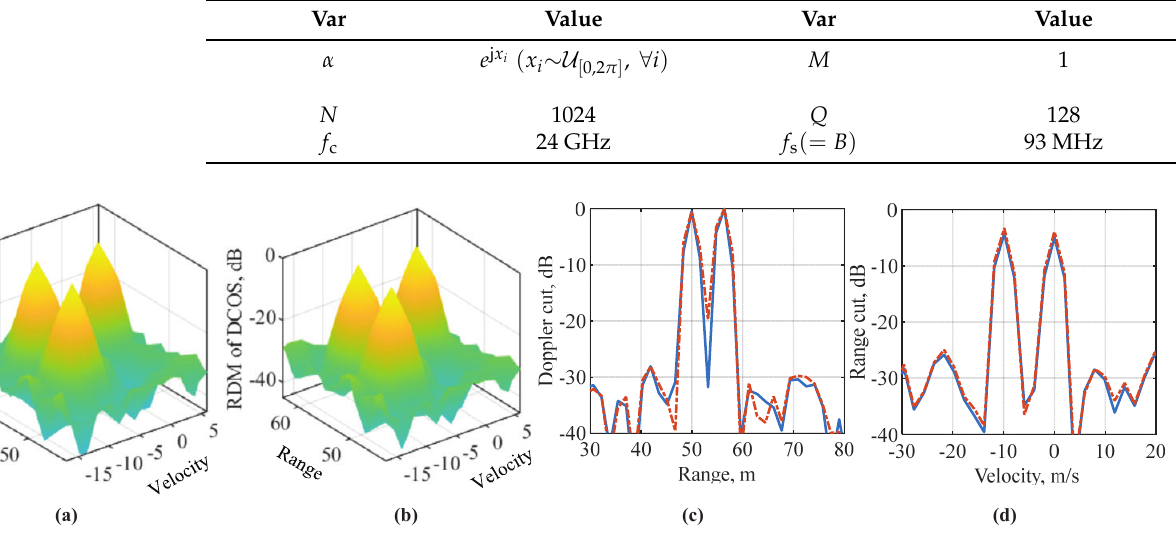
Figure 8. Illustration of target detection, where COS-RDM is given in ( a ), DCOS-RDM in ( b ), the range cuts at v = − 10 m/s are shown in ( c ) and the velocity cuts at r = 56 m in ( d ). Most settings in Table 3 are again used here, except that the number of OFDM symbols is M = 256 and the hamming window is used in (8) and (18) for both range and velocity measurements. In addition, three targets are set here. Their ranges and velocities are [ 50,56, 56 ] m and [ − 10, − 10,0 ] m/s, respectively. Note that the symbol “-” in the axes of all subfigures is the minus sign (not